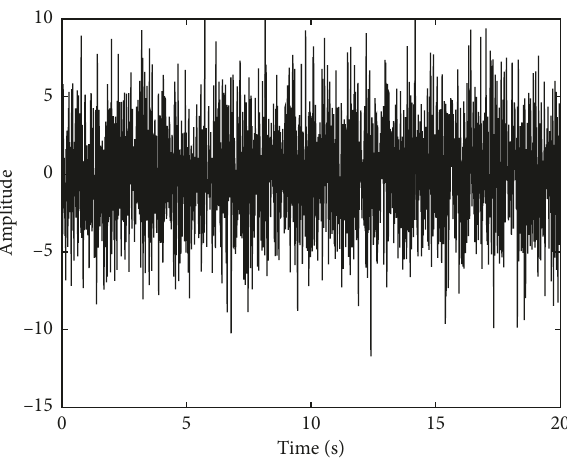
Figure 3: Waveform of LFM